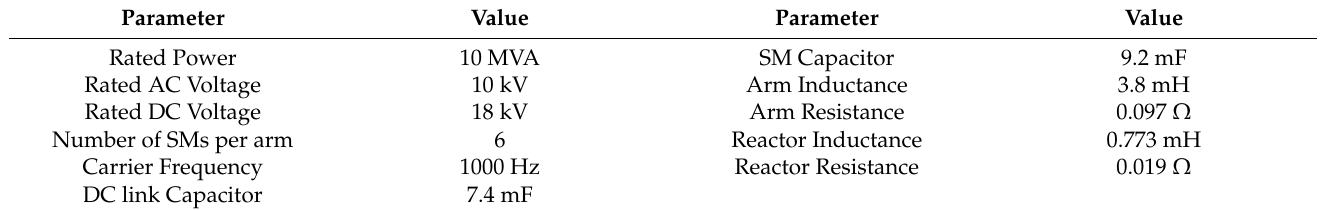
Table 3. Parameters of MMC.